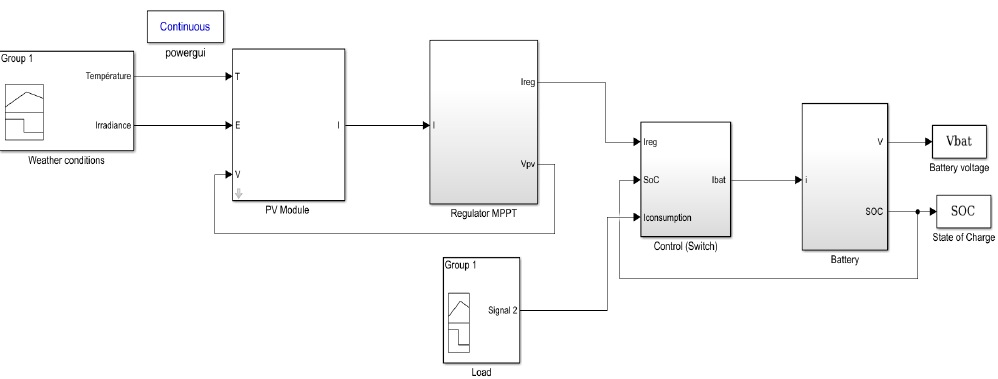
Figure 7. The MG Simulink model used for simulations.